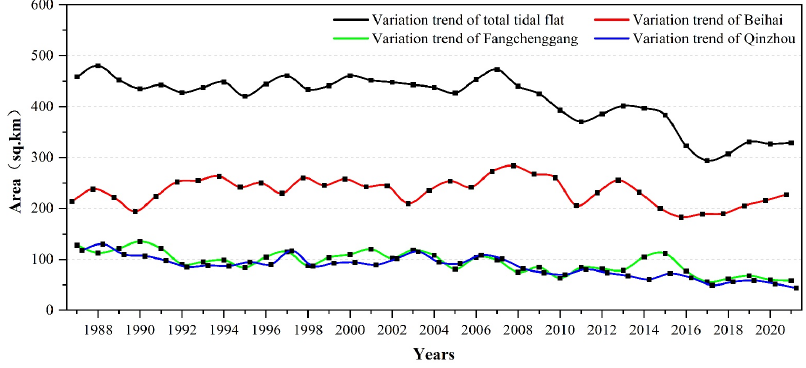
Figure 11. Statistics of total tidal flat area in Beibu Gulf, 1987–2021.